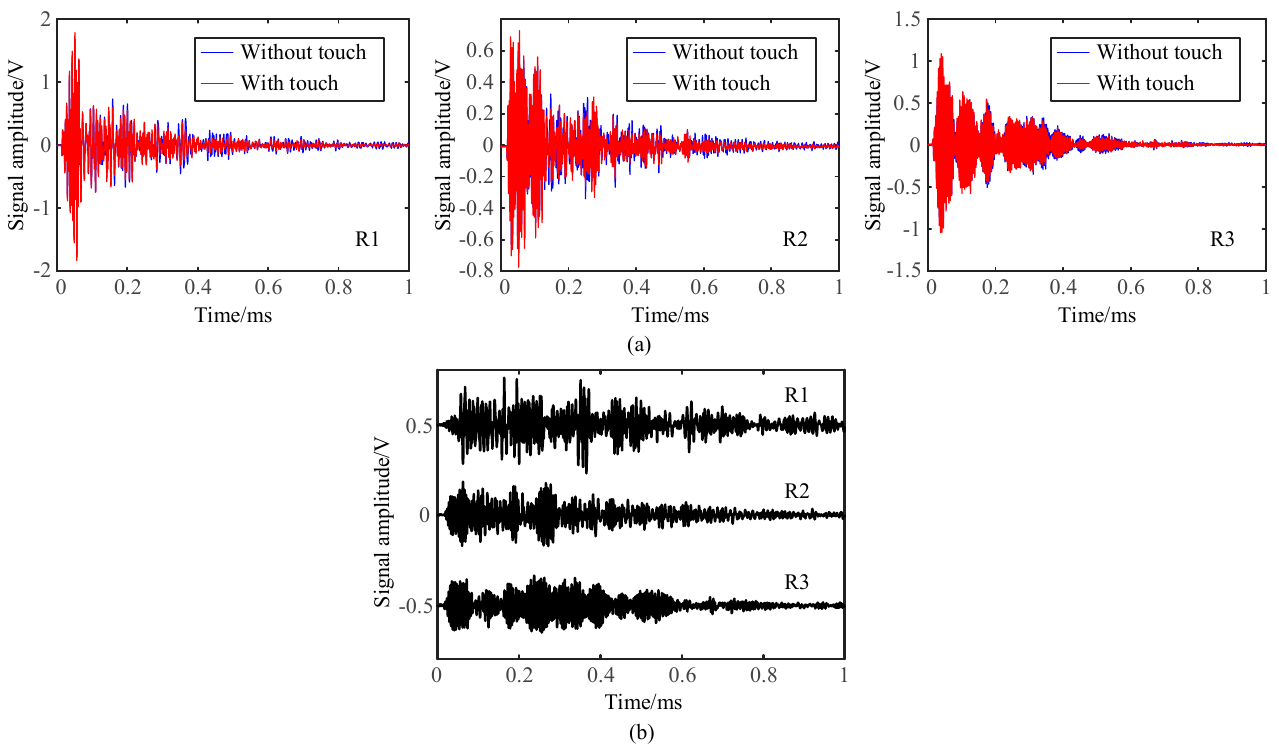
Figure 3. Typical acoustic fingerprints: ( a ) typical signals received with and without touch action and ( b ) disturbances of acoustic fingerprint caused by the touch action.